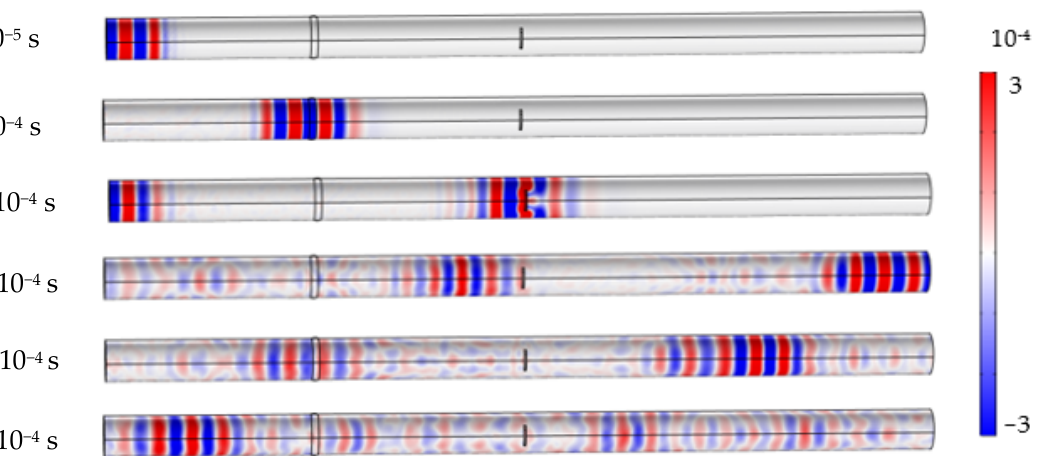
Figure 14. Wave propagation through the entire span of the pipe: ( a – f ).